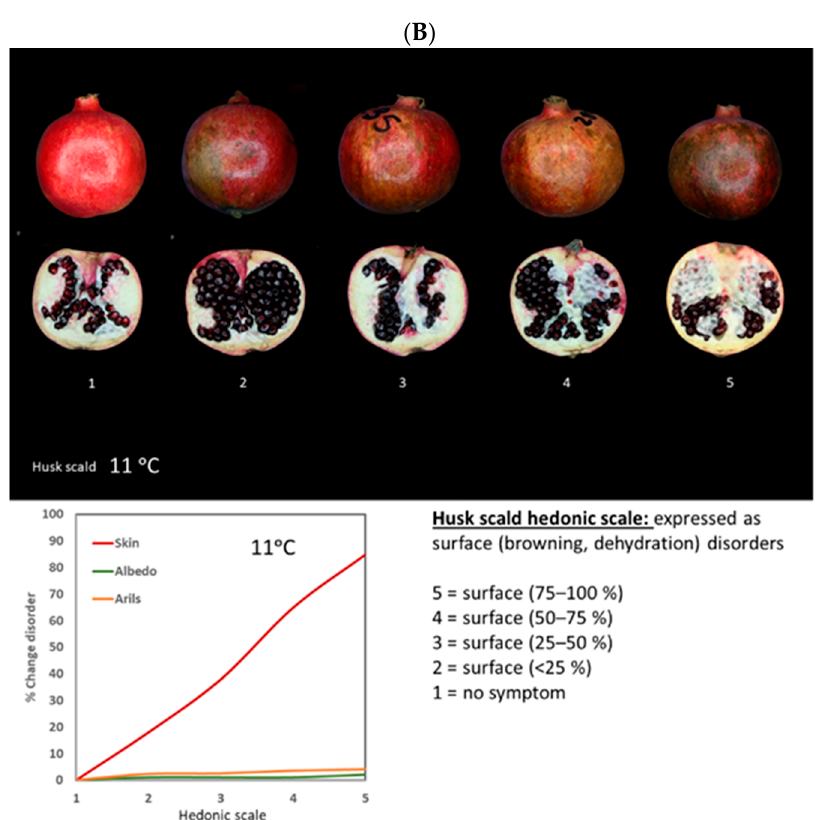
Figure 3. Comparison of quality changes during chilling injury (CI) and husk scald (HS) in ‘Won- derful’ pomegranate fruit. ( A ) Numeric 1–5 hedonic scale for CI in pomegranates stored at 3.5 °C developed within a period of 120 days including visual appearance changes in skin, albedo, and arils. ( B ) Numeric 1–5 hedonic scale for HS in pomegranates stored at 11 °C developed within a period of 120 days including visual appearance changes in skin, with no e ff ects in albedo and arils.